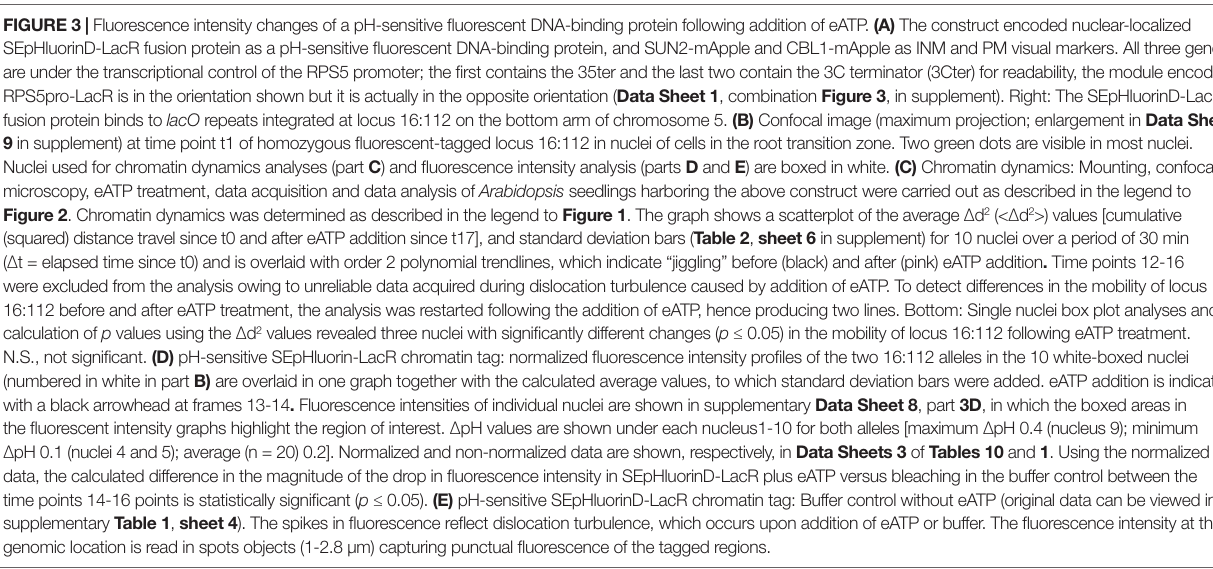
FIGURE 3 | Fluorescence intensity changes of a pH-sensitive fluorescent DNA-binding protein following addition of eATP. (A) The construct encoded nuclear-localized SEpHluorinD-LacR fusion protein as a pH-sensitive fluorescent DNA-binding protein, and SUN2-mApple and CBL1-mApple as IN﻿ and P﻿ visual markers. All three genes are under the transcriptional control of the RPS5 promoter; the first contains the 35ter and the last two contain the 3C terminator (3Cter) for readability, the module encoding RPS5pro-LacR is in the orientation shown but it is actually in the opposite orientation ( Data Sheet 1 , combination Figure 3 , in supplement). Right: The SEpHluorinD-LacR fusion protein binds to lacO repeats integrated at locus 16:112 on the bottom arm of chromosome 5. (B) Confocal image (maximum projection; enlargement in Data Sheet 9 in supplement) at time point t1 of homozygous fluorescent-tagged locus 16:112 in nuclei of cells in the root transition zone. Two green dots are visible in most nuclei. Nuclei used for chromatin dynamics analyses (part C ) and fluorescence intensity analysis (parts D and E ) are boxed in white. (C) Chromatin dynamics: ﻿ounting, confocal microscopy, eATP treatment, data acquisition and data analysis of Arabidopsis seedlings harboring the above construct were carried out as described in the legend to Figure 2 . Chromatin dynamics was determined as described in the legend to Figure 1 . The graph shows a scatterplot of the average Δd 2 (<Δd 2 >) values [cumulative (squared) distance travel since t0 and after eATP addition since t17], and standard deviation bars ( Table 2 , sheet 6 in supplement) for 10 nuclei over a period of 30 min (Δt = elapsed time since t0) and is overlaid with order 2 polynomial trendlines, which indicate “jiggling” before (black) and after (pink) eATP addition . Time points 12-16 were excluded from the analysis owing to unreliable data acquired during dislocation turbulence caused by addition of eATP. To detect differences in the mobility of locus 16:112 before and after eATP treatment, the analysis was restarted following the addition of eATP, hence producing two lines. Bottom: Single nuclei box plot analyses and calculation of p values using the Δd 2 values revealed three nuclei with significantly different changes ( p ≤ 0.05) in the mobility of locus 16:112 following eATP treatment. N.S., not significant. (D) pH-sensitive SEpHluorin-LacR chromatin tag: normalized fluorescence intensity profiles of the two 16:112 alleles in the 10 white-boxed nuclei (numbered in white in part B) are overlaid in one graph together with the calculated average values, to which standard deviation bars were added. eATP addition is indicated with a black arrowhead at frames 13-14 . Fluorescence intensities of individual nuclei are shown in supplementary Data Sheet 8 , part 3D , in which the boxed areas in the fluorescent intensity graphs highlight the region of interest. ΔpH values are shown under each nucleus1-10 for both alleles [maximum ΔpH 0.4 (nucleus 9); minimum ΔpH 0.1 (nuclei 4 and 5); average (n = 20) 0.2]. Normalized and non-normalized data are shown, respectively, in Data Sheets 3 of Tables 10 and 1 . Using the normalized data, the calculated difference in the magnitude of the drop in fluorescence intensity in SEpHluorinD-LacR plus eATP versus bleaching in the buffer control between the time points 14-16 points is statistically significant ( p ≤ 0.05). (E) pH-sensitive SEpHluorinD-LacR chromatin tag: Buffer control without eATP (original data can be viewed in supplementary Table 1 , sheet 4 ). The spikes in fluorescence reflect dislocation turbulence, which occurs upon addition of eATP or buffer. The fluorescence intensity at the genomic location is read in spots objects (1-2.8 μm) capturing punctual fluorescence of the tagged